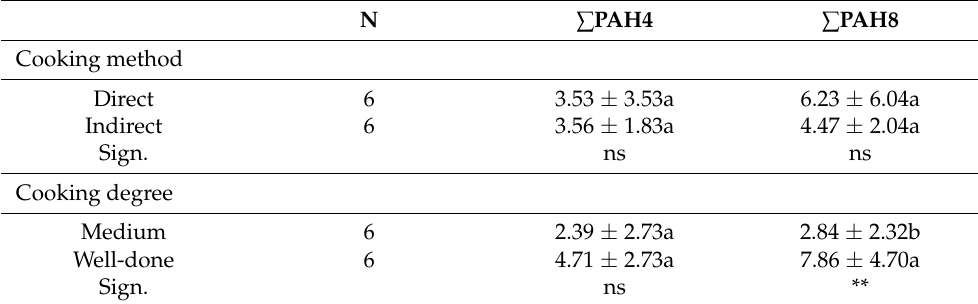
Table 3. ∑ PAH4 and ∑ PAH8 contents of the meat samples cooked using direct and indirect cooking methods at different cooking degrees (mean ± SD). N ∑ PAH4 ∑